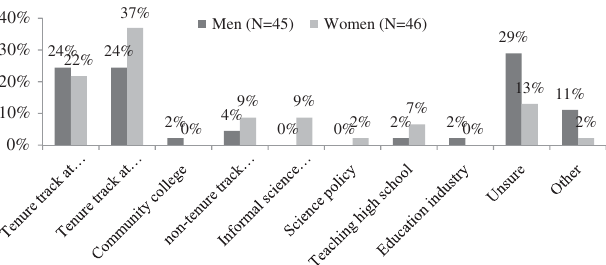
FIG. 7. Students who agreed to being comfortable with given groups. (Note: the neutral and disagree responses are not shown for the sake of simplicity).